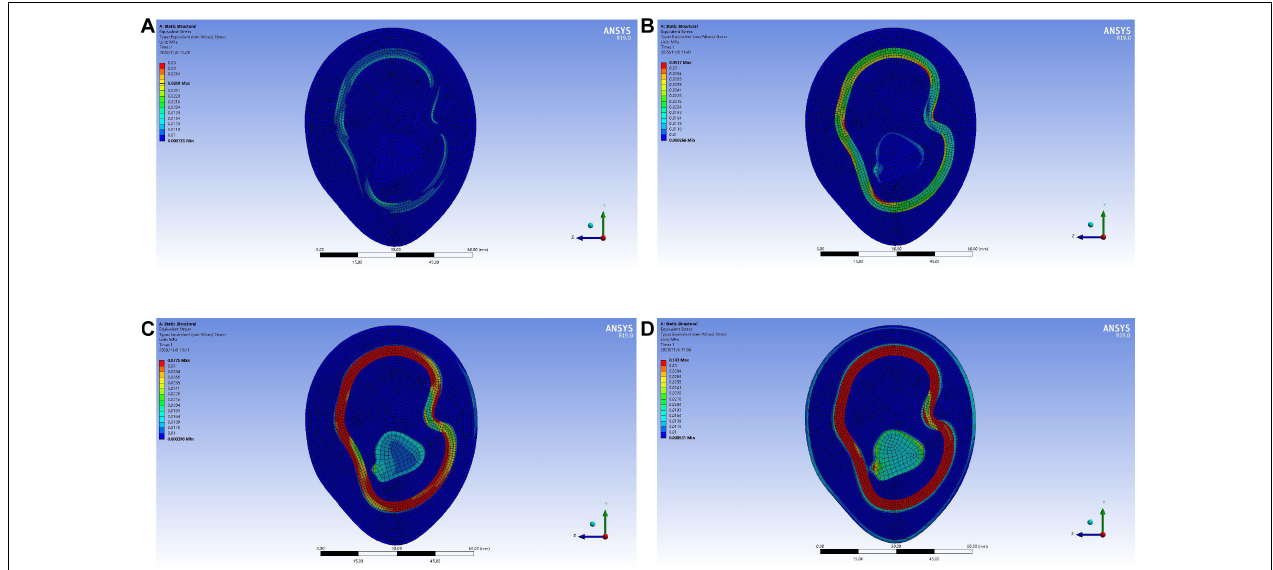
FIGURE 10 | Rainbow diagram of pressure distribution in the lymph and blood layers of the upper arm model under different external pressure loads: (A) 002 MPa external pressure, (B) 0.004 MPa external pressure, (C) 0.006 MPa external pressure, and (D) 0.008 MPa external pressure.